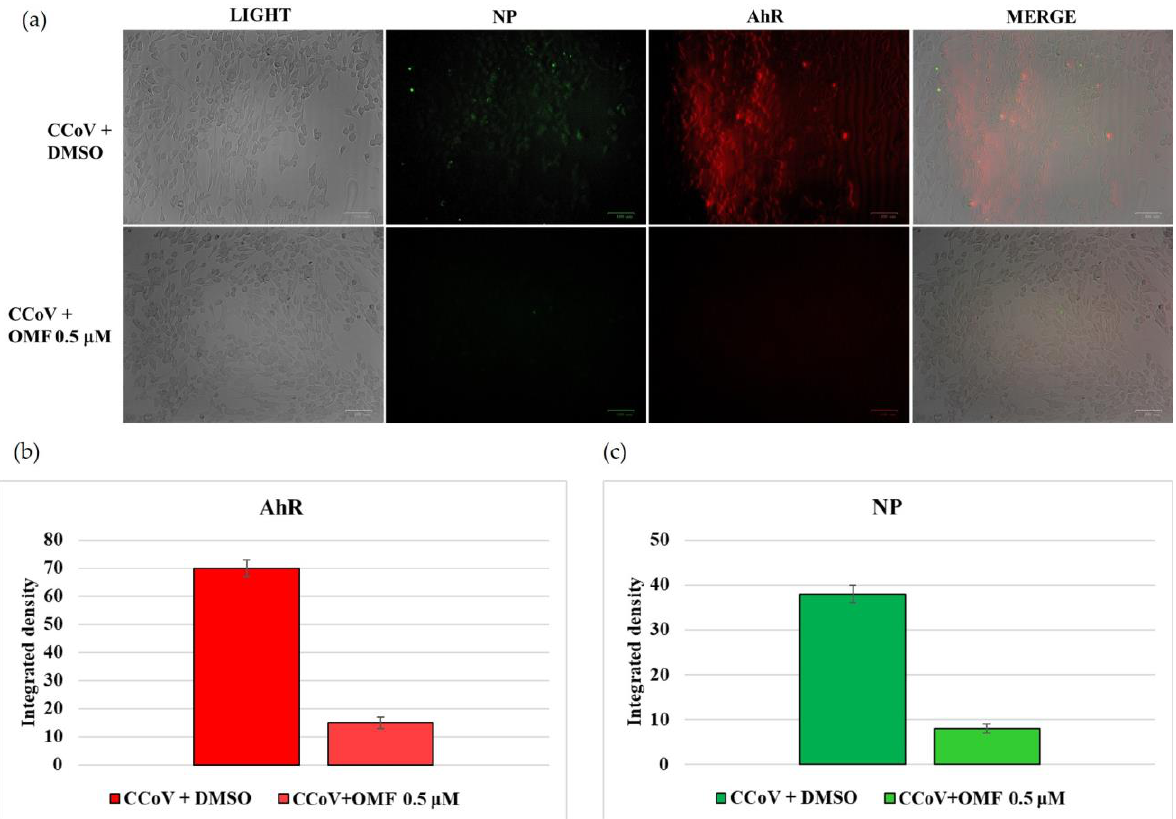
Figure 7. OMF decreased AhR and NP expression during CCoV infection in A72 cells. Cells were infected with CCoV at a MOI of five, and exposed or not to OMF; at 24 h after infection, IF staining to detect AhR (red fluorescence) and NP (green fluorescence) was carried out. ( a ) In OMF-exposed groups, the expression of AhR and NP was extremely decreased during CCoV infection. Scale bar 100 μ m. ( b ) Bars correspond to the mean ratio obtained from the integrated density in the expression of AhR calculated using ImageJ. Error bars correspond to standard error quantification. ( c ) Bars correspond to the mean ratio obtained from the integrated density in the expression of NP calculated using ImageJ. Error bars correspond to standard error quantification.